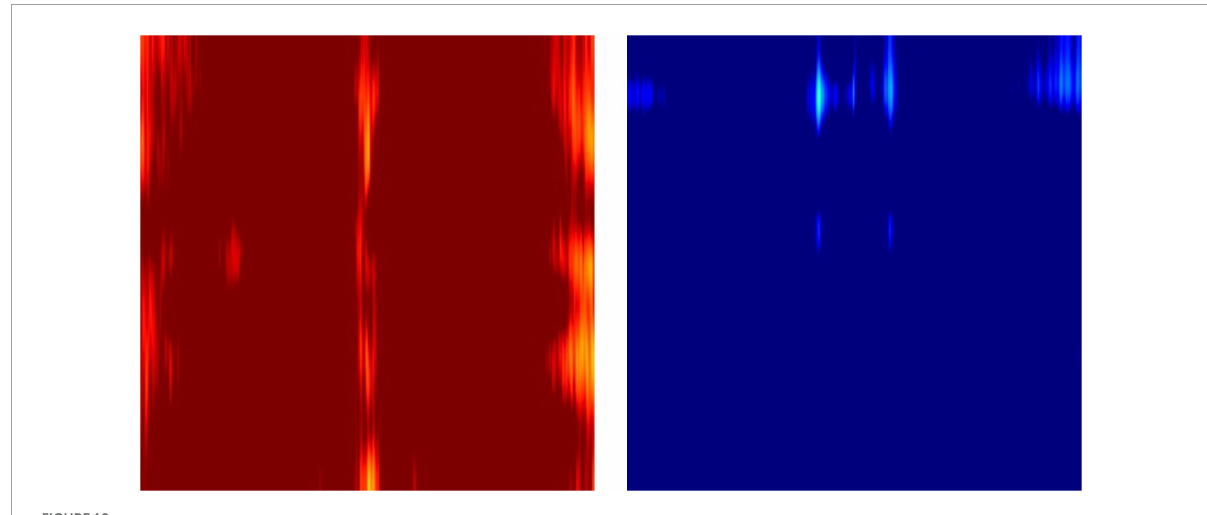
FIGURE10 Example outlier images that represent absolute Z-scores of electroencephalography (EEG) power